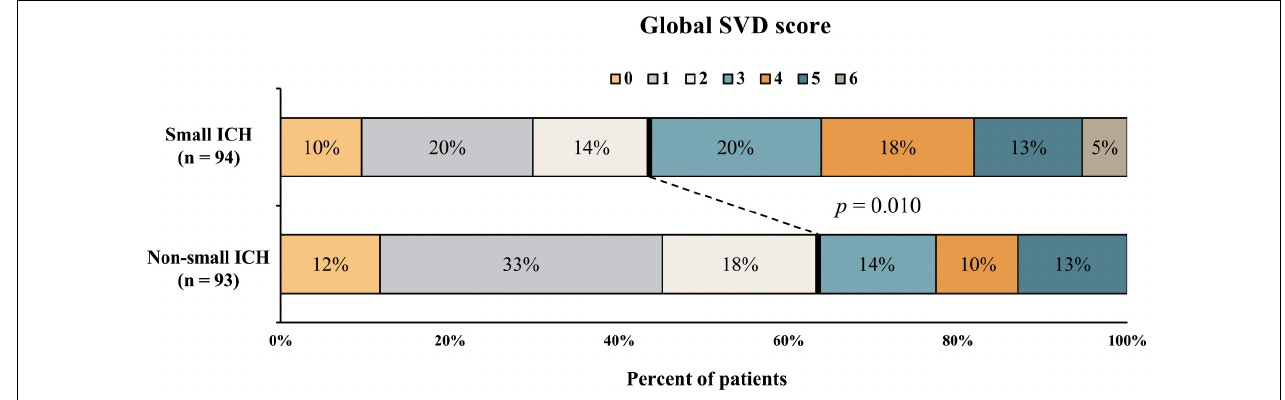
FIGURE 2 | Distribution of small vessel disease (SVD) severity in patients with small and non-small intracerebral hemorrhage (ICH). TABLE 3 | The multivariate logistic regression analysis of variables associated with small ICH adjusted for age and male sex. Total cohort Lobar ICH Non-lobar ICH aOR 95% CI p -value aOR 95% CI p -value aOR 95% CI p -value